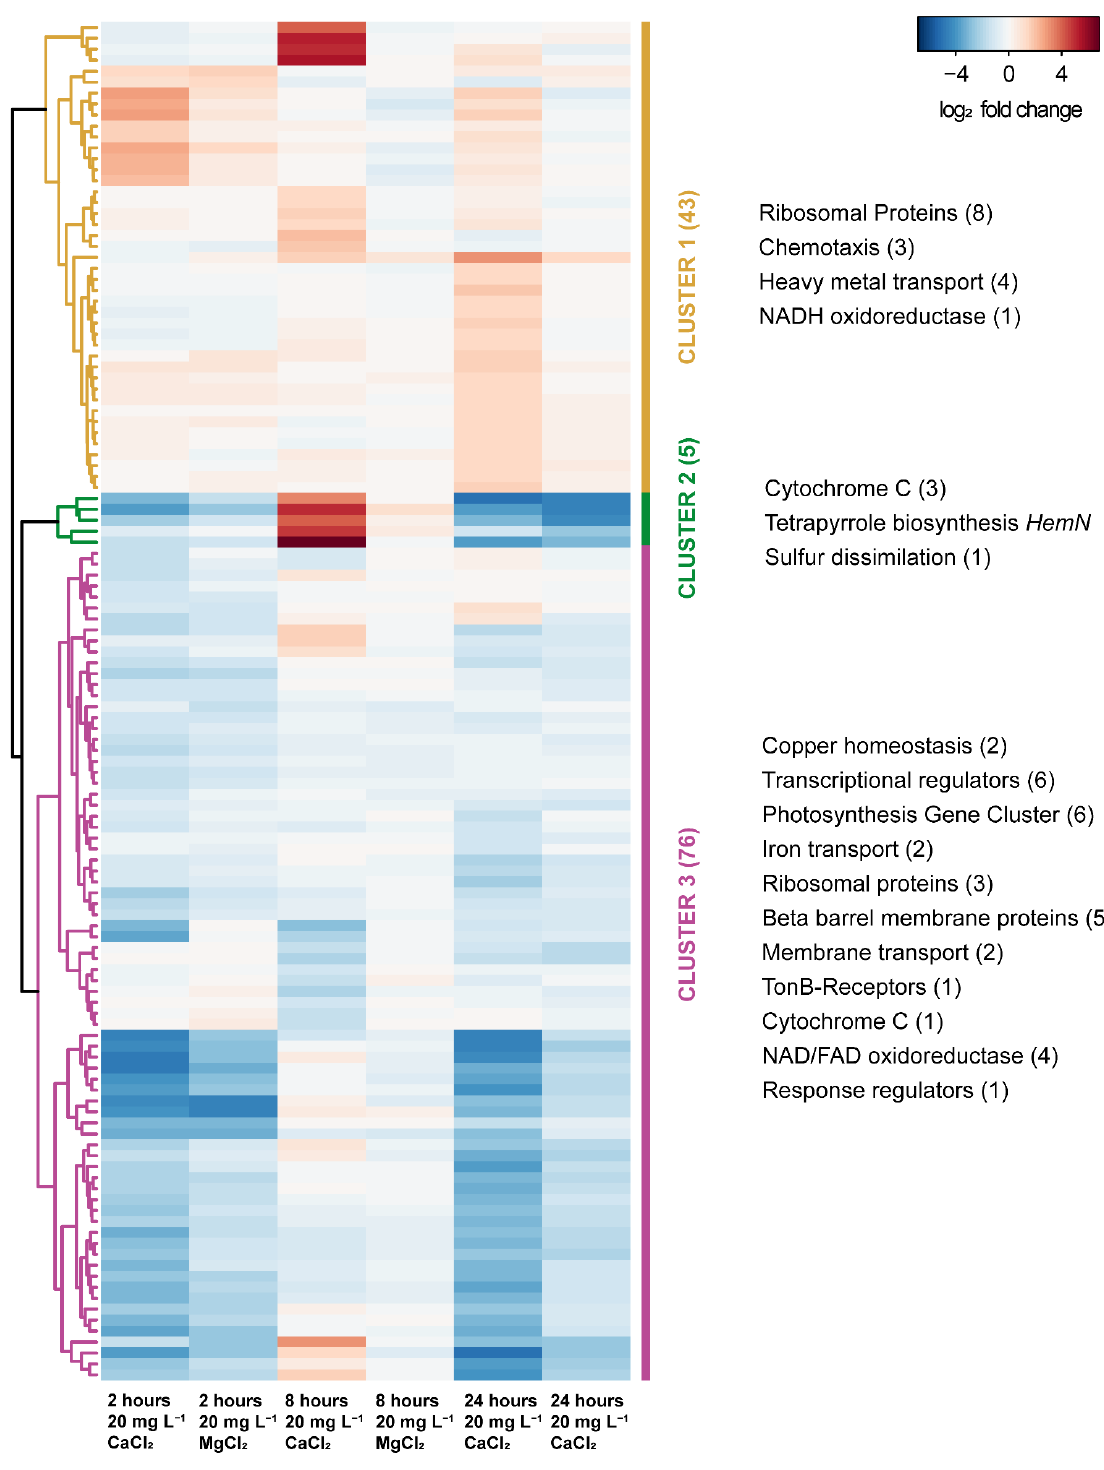
Figure 7. Heatmap and hierarchical clustering based on the Euclidean distance of the log2 FC of significantly differentially expressed genes in 20 mg CaCl 2 L −1 and 20 mg MgCl 2 L −1 at 2 h, 8 h, and 24 h after amendment. The colors indicate three clusters obtained by cutting the tree at the earliest branching points. Functions of genes within the clusters are noted on the left with the numbers of coding genes in brackets.